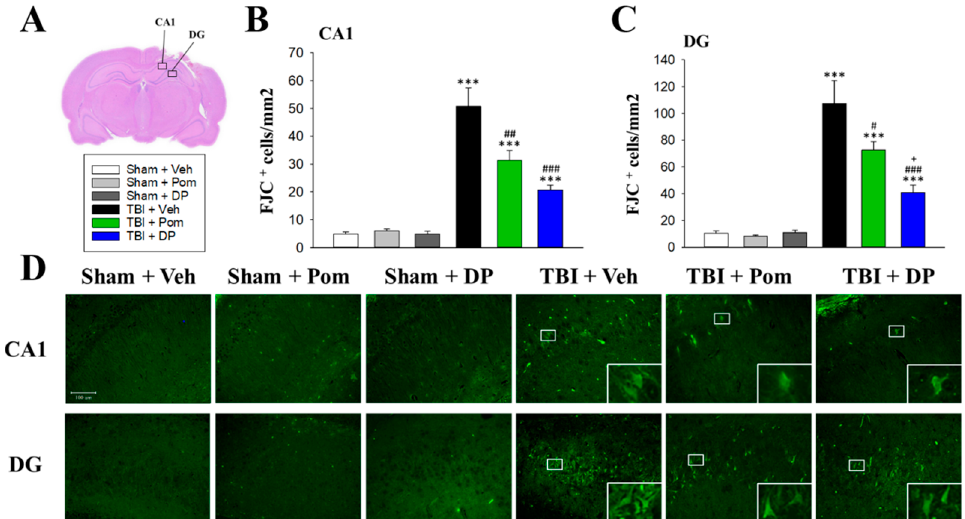
Figure 5. Post-injury administration of Pom or DP reduced degenerating neurons in the hippocampus 7 days after a TBI, with DP having better efficacy than Pom in the DG. ( A ) Representative image of an HE-stained coronal brain section from a TBI + Veh rat that shows the areas of evaluation at 7 days after a TBI. Quantitative comparison of mean densities of FJC+ cells in the hippocampal CA1 ( B ) and DG ( C ) regions at 7 days after a TBI. ( D ) Representative photomicrographs showing the FJC-stained hippocampal CA1 and DG regions from various groups at 7 days after a TBI. Data are expressed as the mean ± S.E.M. *** p < 0.001 versus Sham + Veh group; # p < 0.05, ## p < 0.01, ### p < 0.001 versus TBI + Veh group; + p < 0.05 versus TBI + Pom group ( n = 5 in each group). Statistical difference was analyzed using independent sample t-tests and one-way ANOVA, followed by Tukey’s post hoc comparisons. Scale bar: 100 µ m.